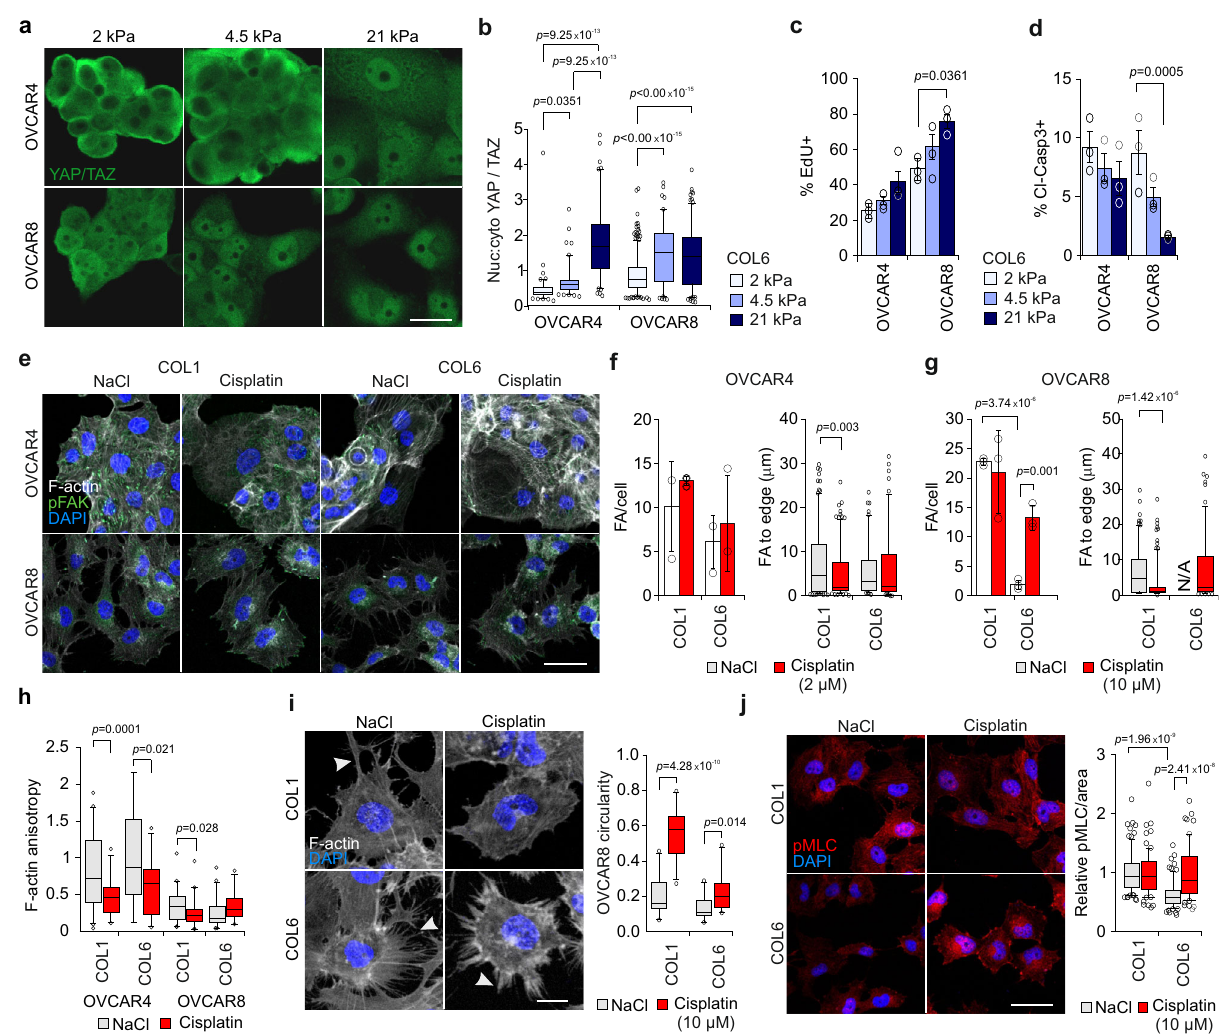
Fig. 7 Cisplatin treatment enhances integrin-based cancer cell adhesion on stiff collagen 6 substrate. a , b Representative confocal micrographs ( a ) and corresponding nuclear to cytoplasmic ratio (nuc:cyto; b ) of YAP/TAZ (green) in cells on 2, 4.5, and 21 kPa collagen 6-functionalized polyacrylamide hydrogels (COL6-PAA) at 48 h; OVCAR4 n = 114/111/103 and OVCAR8 374/265/165 cells, respectively; Scale bar = 10 µ m. c , d Charts depict positivity for EdU in untreated ( c ) and cleaved caspase3 in treated (cl-Casp3; d ) cells on corresponding COL6-PAA at 24 h; see Supplementary Fig. 14c, d for representative micrographs. e – g Representative confocal micrographs of F-actin (phalloidin, white) and phosphorylated focal adhesion (pFAK, green) in cells on 21 kPa COL1 or COL6-PAA at 48 h. Charts show the number and peripheral localization of FAs in OVCAR4 ( f n = 186/191 and 103/105) and in OVCAR8 ( g n = 118/195 and not applicable (N/A)/103). Scale bar = 25 µ m. h Chart depicts the F-actin anisotropy in cells on 21 kPa COL1 or COL6-PAA at 48 h; OVCAR4 n = 47/35, 18/30 and OVCAR8 n = 44/41, 46/27 cells, respectively. See Fig. 7e for representative micrographs. i Representative confocal micrographs of F-actin (phalloidin, white) in OVCAR8 on 21 kPa COL1 and COL6-PAA at 24 h; n = 25 cells. White arrows indicate protrusions. Scale bar = 10 µ m. j Representative confocal micrographs of myosin light chain (pMLC, red) in OVCAR8 on 21 kPa COL1 and COL6-PAA at 24 h. Chart indicates pMLC staining intensity per area; n = 86/72 and 75/65 cells, respectively. Scale bar = 25 µ m. Data represent mean ± SEM of biological replicates ( n = 3 in b , d – j , n = 4 in c ). One-way ANOVA with Tukey ’ s multiple comparison test ( b , f , g , i , j , l ); two-tailed Student ’ s t test ( c , d , h ). Box plots indicate median (middle line), 25th, 75th percentile (box), and 10th and 90th percentile (whiskers) as well as outliers (single points). Source data are provided as a Source data fi